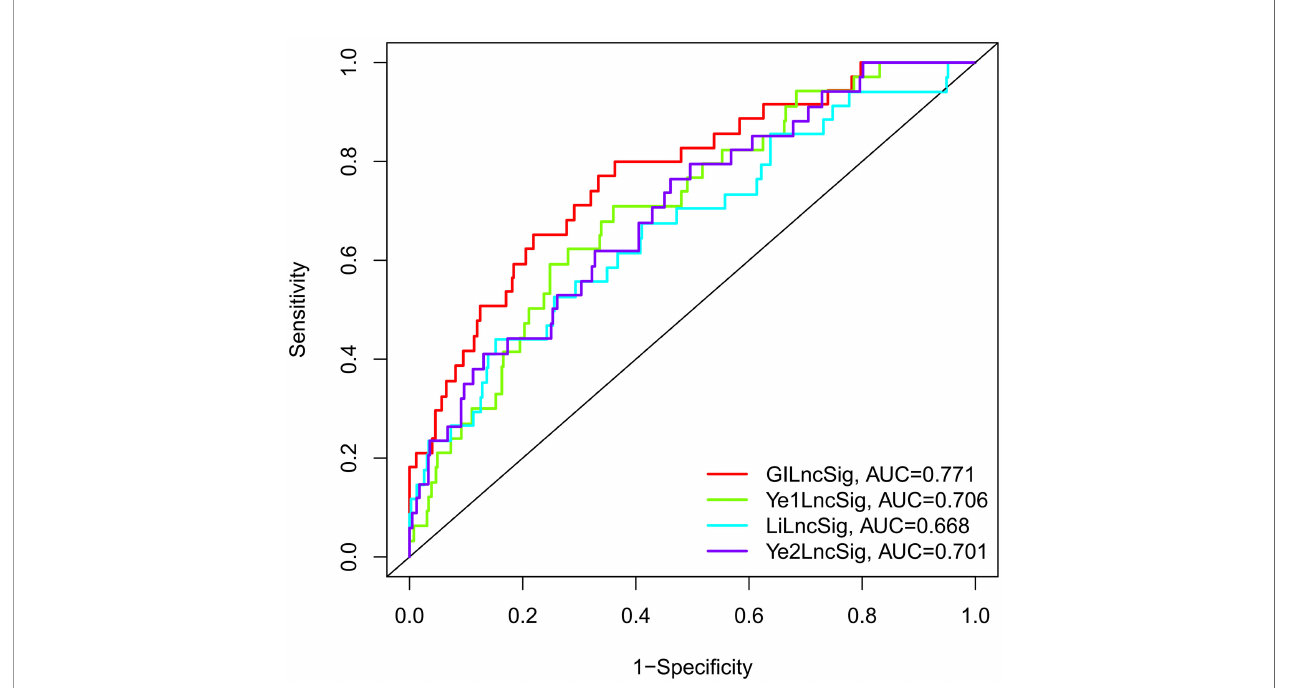
FIGURE 6 | The ROC analysis at biochemical recurrence for the GILncSig, Ye1lncSig, Ye2lncSig, and